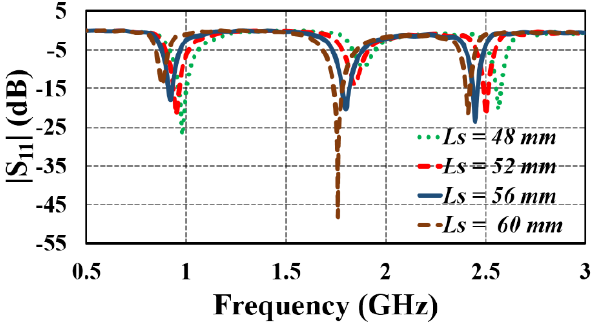
Figure 2: |S 11 | dB variation versus frequency for initial PIFA design, with and without fractal slit, and along with a parasitic strip.